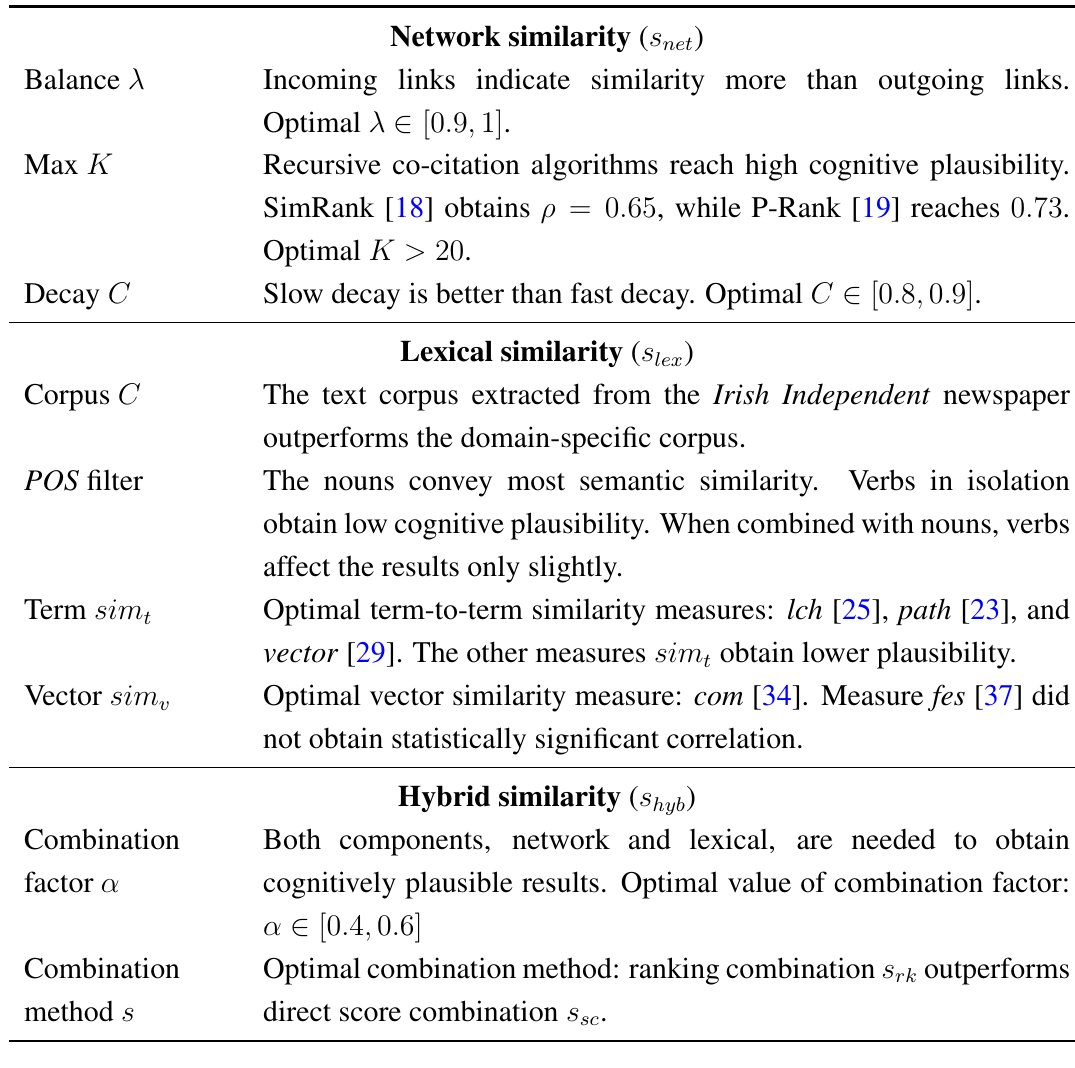
Table 7. Summary of optimal parameter values for network, lexical and hybrid